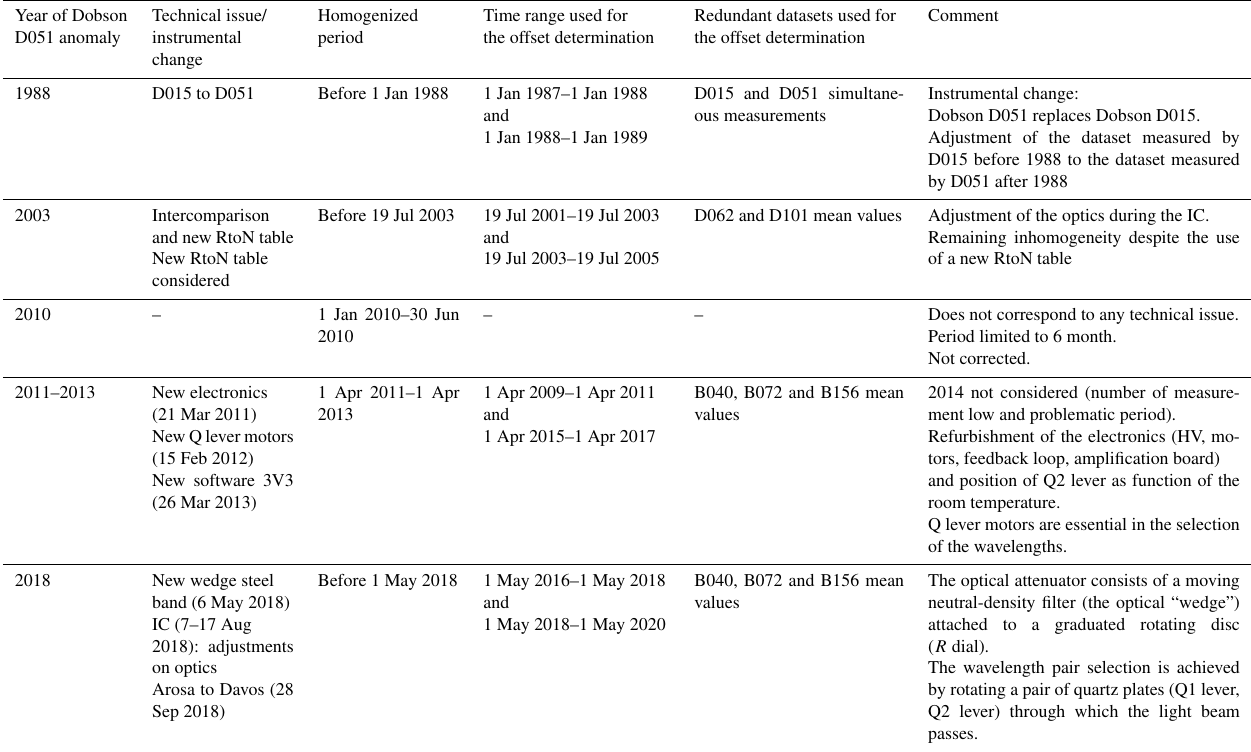
Table 2. Dobson D051 homogenization description: determined time of Dobson D051 anomaly, technical issues or instrumental change which is considered as the source of the anomaly, the homogenized period, time ranges for the offset calculation, redundant datasets used for the offset calculation and details of the technical